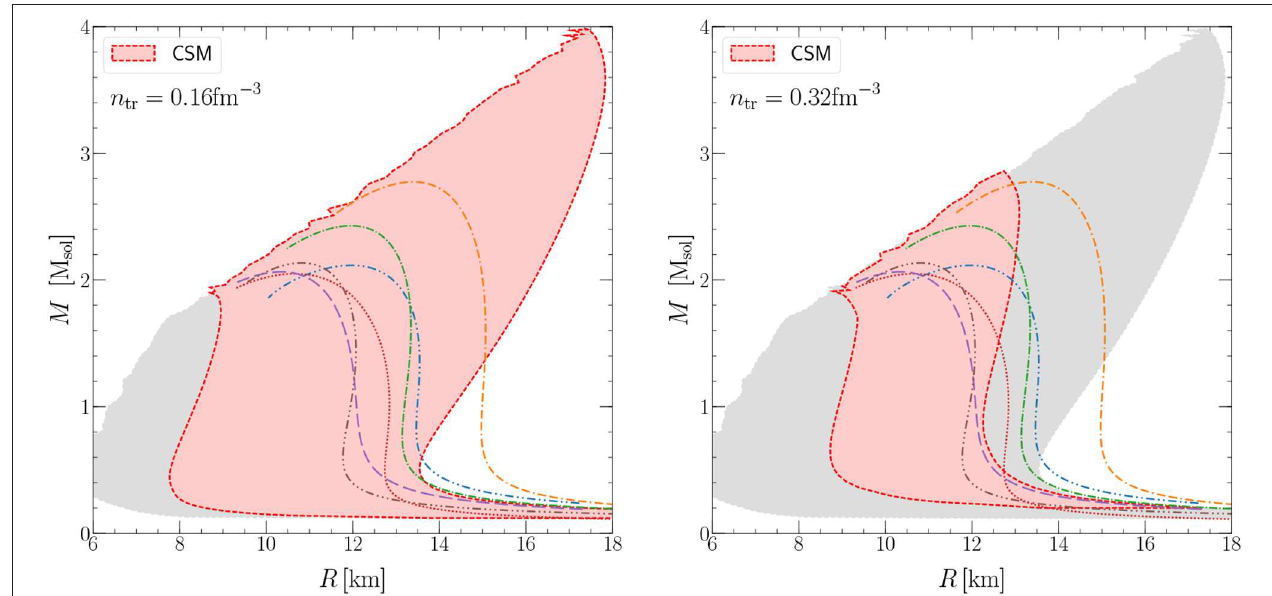
n sat (left) and n tr FIGURE 6 | Mass-radius envelopes for n tr 2 n sat (right) . We show the EOS envelope given all constraints (red area), as well as the MR space = = that is ruled out by the two-solar mass constraint and/or when enforcing chiral EFT constraints up to larger densities (gray areas). The results are compared to the same EOSs shown in Figure 4 . Adapted by permission from Springer Nature, Tews et al. [ 50], copyright 2019.